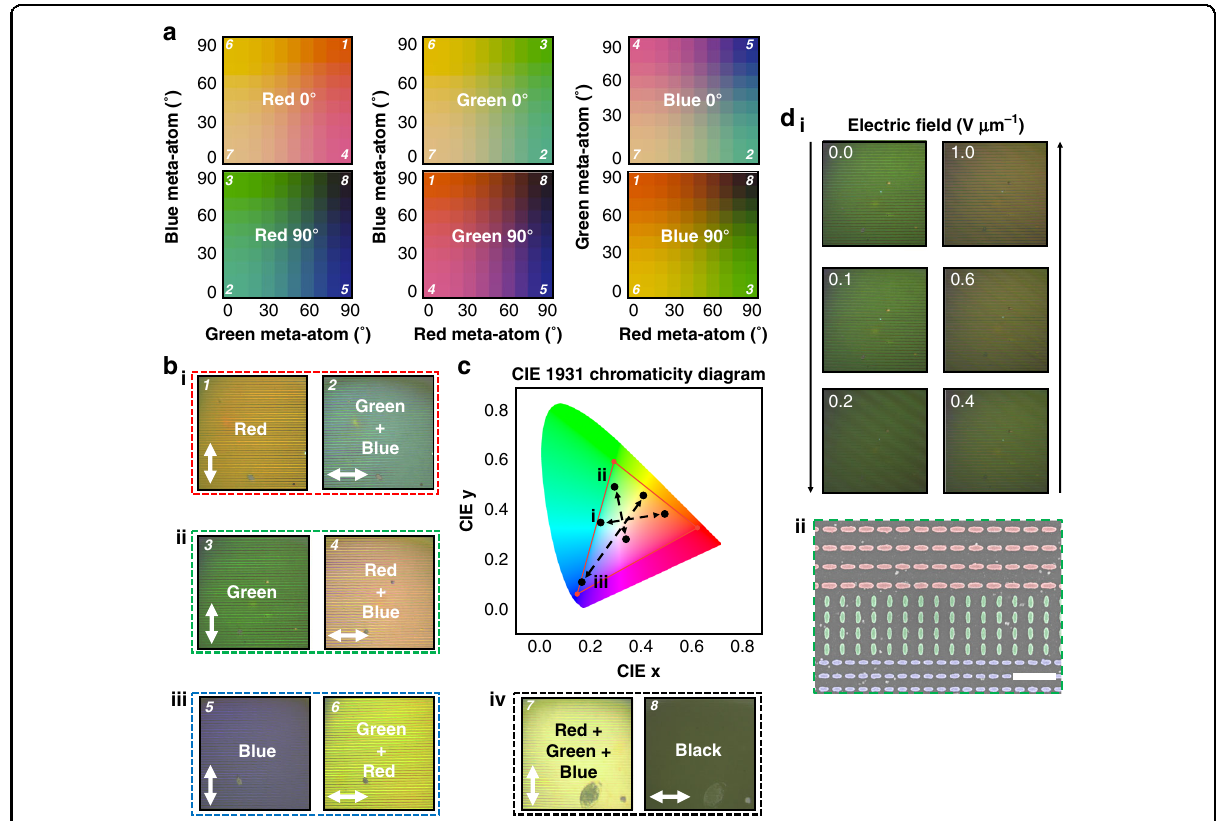
Fig. 5 Electrically tunable color pixels for re fl ective displays. a Calculated color palettes by combining the measured re fl ectance spectra of the red, green, and blue metasurfaces with rotated meta-atoms in a 1:1:1 ratio. b Fabricated metasurfaces with rotated subpixels for (i) red, (ii) green, (iii) blue, and (iv) white colors. Under LP 0°, two colors are successfully mixed to produce (i) cyan, (ii) magenta, and (iii) yellow, while under LP 90°, the desired primary color is produced. The numbers in ( b ) are indicated in the color palettes in ( a ). The white arrows denote the L ̂ axis. c Corresponding locations of the mixed colors on the CIE 1931 Chromaticity Diagram. (i), (ii), and (iii) refer to the samples in ( b ). The red line indicates the sRGB color gamut. d (i) Experimental demonstration of the electrical tunability of the color pixels using the fabricated metasurface in ( b -ii) along with the LC cell. The color is modulated from green through to gray, and fi nally to magenta upon the application of electric fi eld. (ii) Faux-colored scanning electron microscope image of the metasurface showing the subpixel layout for the measured sample. The scale bar represents 1